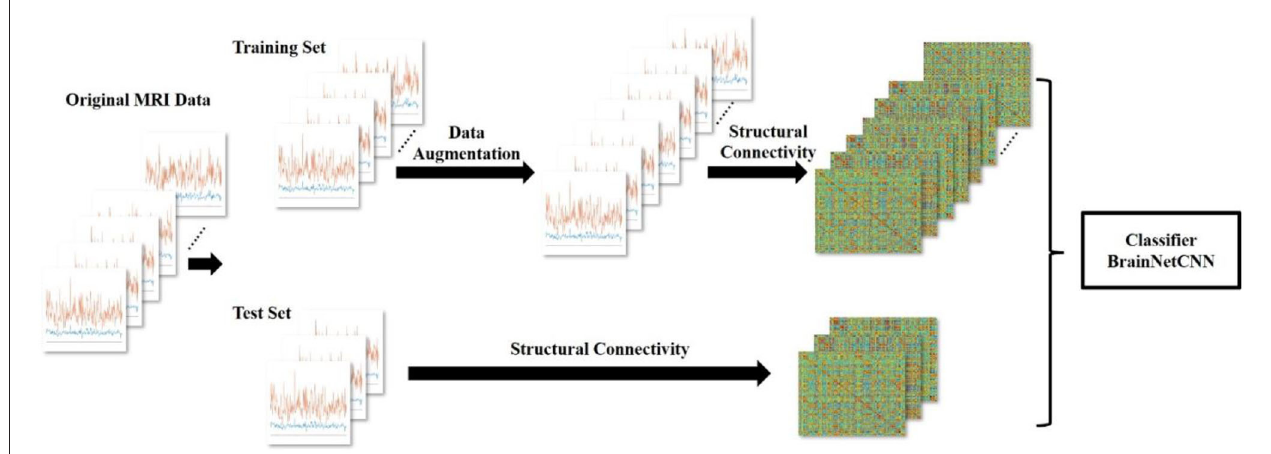
FIGURE 1 | Overview of the process for the data augmentation of the gifted children MRI dataset using GEMD. From left to right, the seven curves representing the morphometric features in the 308 regions of the brain, for each subject (original MRI data). Then, the data are split into training and test sets; the training set is augmented using GEMD; the structural connectivity of the data is calculated and used to feed the deep learning model. Finally, the structural connectivity is also derived for the samples of the test set to demonstrate the capability of the classifier.